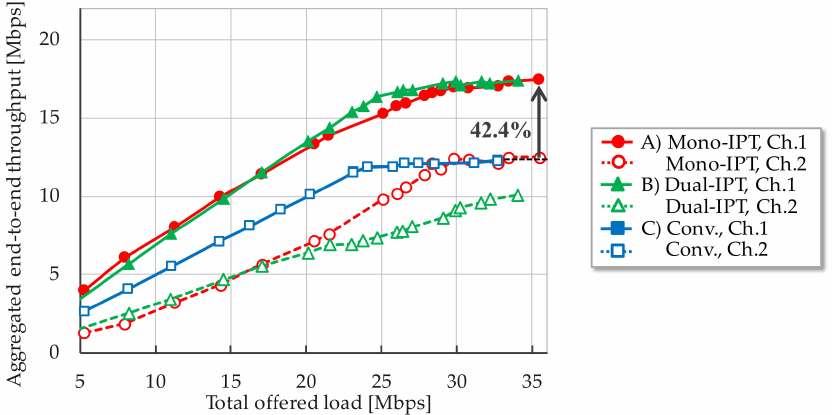
Figure 9. System throughput for each